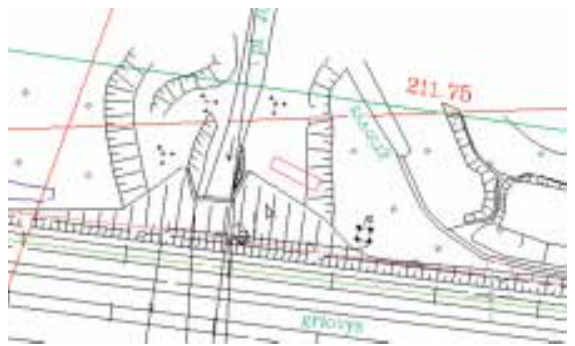
Fig 1. Distribution of aerial photograph centres on the objects’ site